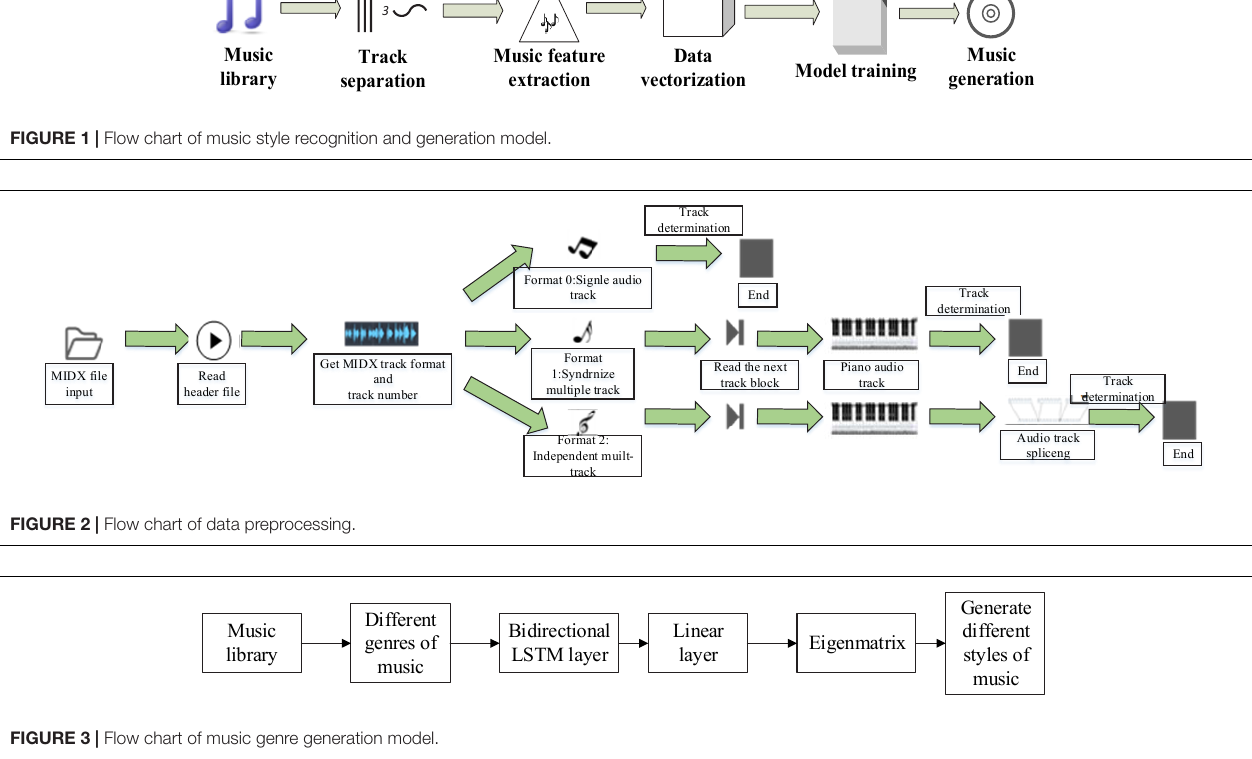
FIGURE 3 | Flow chart of music genre generation model.